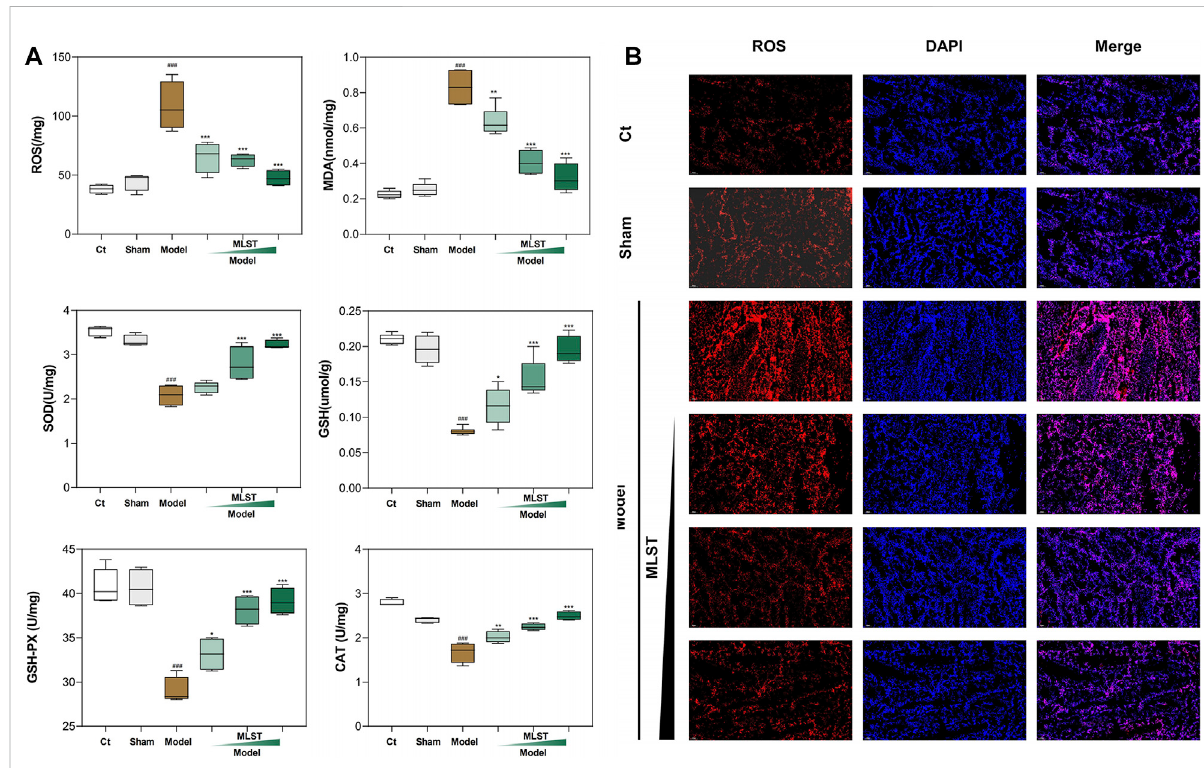
FIGURE 5 Effect of MLST treatment on VC-induced biomarkers of oxidative stress in rat testis. (A) Oxidative stress biomarkers, including ROS, MDA, SOD, GSH, GSH-Px, CAT; N = 6; # p < 0.05, ## p < 0.01, ### p < 0.001 compared to Ct; * p < 0.05, ** p < 0.01, *** p < 0.001 compared to Model. (B) ROS fl uorescence analysis; Red fl uorescence represents ROS; Blue fl uorescence represents cell